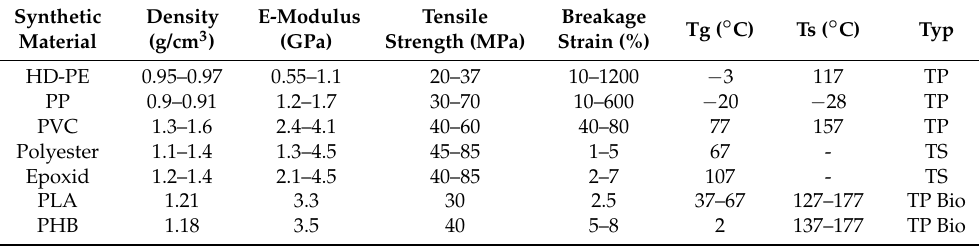
Table 2. Material characteristic and mechanical properties of the matrix materials and typical plastics for comparison (CELC: Flax and Hemp fibres: a natural solution for the composite industry. JEC-Composite,